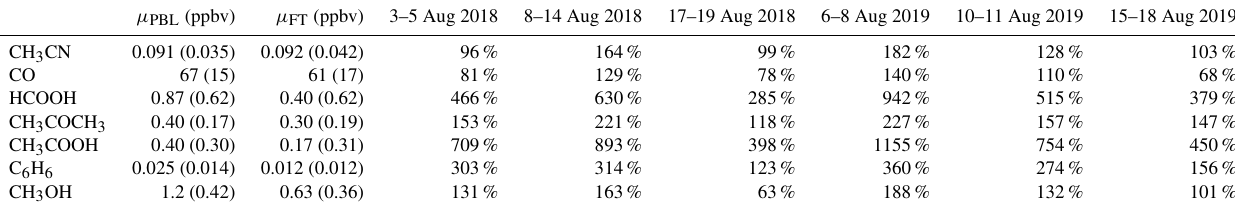
Table 4. Mean background mixing ratio during the daytime (10:00–16:00LT, reflecting planetary boundary layer air composition) and nighttime (22:00–04:00LT, measuring free tropospheric air masses), µ PBL (ppbv) and µ FT (ppbv) respectively, and mean excesses (%) during the August 2018 and August 2019 BB intrusions. The reported background values are mean mixing ratios recorded during austral winter (June, July, August), excluding BB incidents.